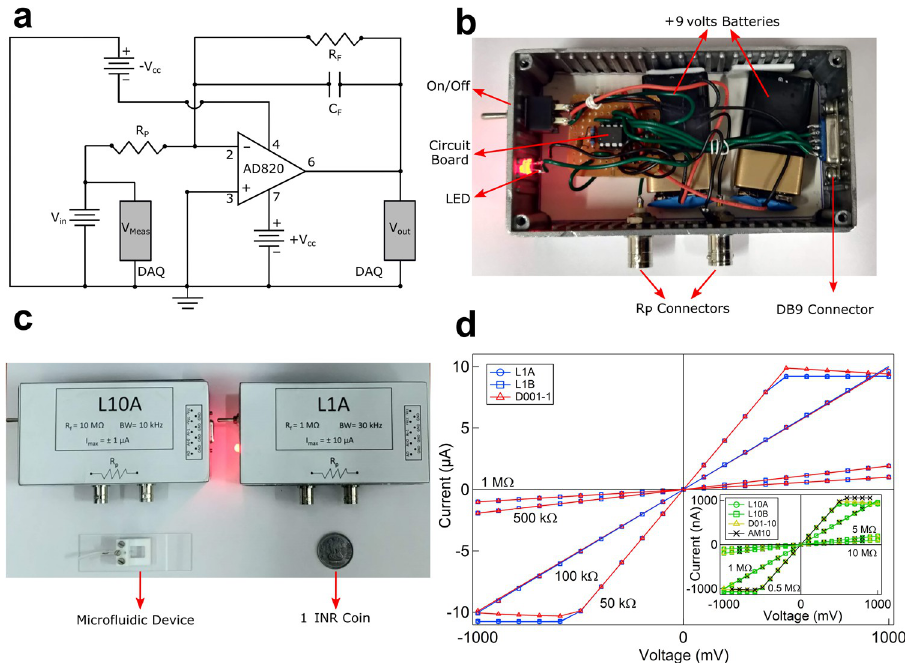
Fig 1. Schematic and construction of low-cost portable amplifier. a Schematic of the electrical circuit of the amplifier. b Image of the soldered circuit board inside the amplifier box with labeled circuit board, On/Off switch, LED, R P connectors (to device) and DB9 connector. The amplifier is powered by two 9 volts DC batteries. c Shows two lab amplifiers (L1 and L10 series), enclosed in an aluminum box with labels showing individual specifications. The micropore device on a glass slide and a 1 INR coin is also shown for size reference. d I-V characteristics of electrical resistors measured with our amplifiers (L1 and L10 (inset), with ± 10 volts V CC ) series where A & B suffix are 2 copies of the same amplifier design) is compared with commercial amplifiers (D and AM series). Online version in